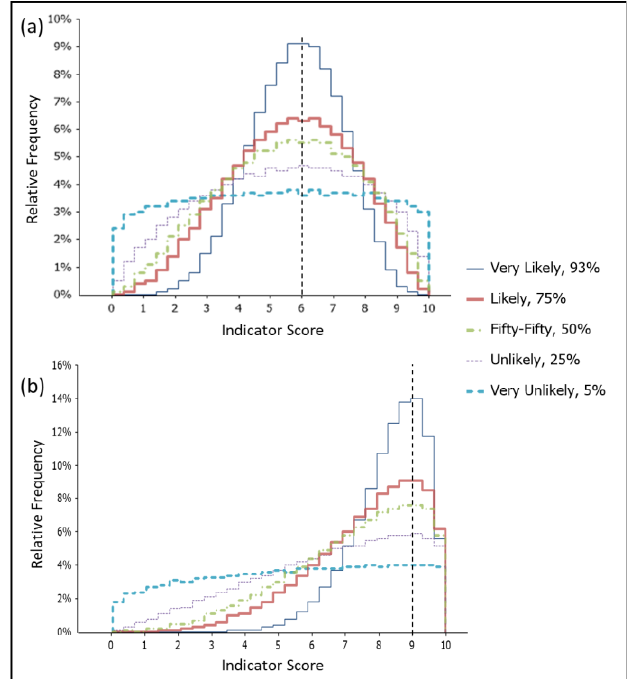
Figure 2. Model input distributions, representing five levels of confidence rating identified as appropriate by subject-matter experts, for an indicator score of 6 and varying levels of confidence around that scoring. Note that the distribution for the 93% confidence (thin, solid line) is most likely to produce a value of 6; although other values (1–10) are possible, they are less likely and are clustered around 6. The distribution for the 5% confidence (thick, dashed line) can produce a value between 0 and 10 with relatively equal likelihood, although lower (0–3) and higher values (8–10) are lightly less likely. ( b ) Model input distributions for an indicator score of 9 and varying levels of confidence around that scoring are likely, ( a ) although they are left-skewed, i.e., with longer tails to the left and clustering to the